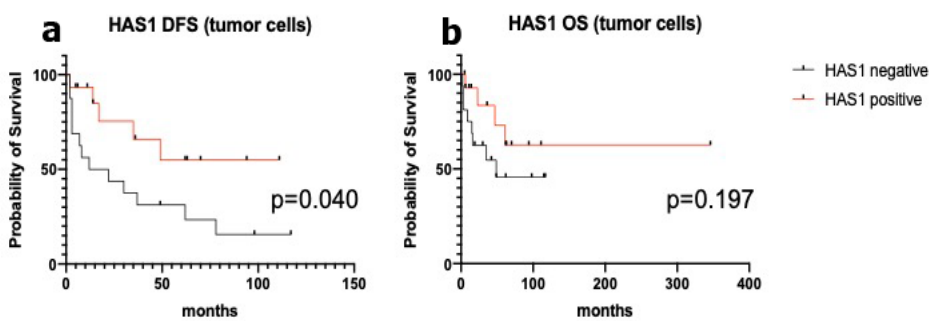
Figure 3. Univariate disease free ( a ) and overall ( b ) survival analysis in HAS-1 tumor cell positive and negative adrenocortical